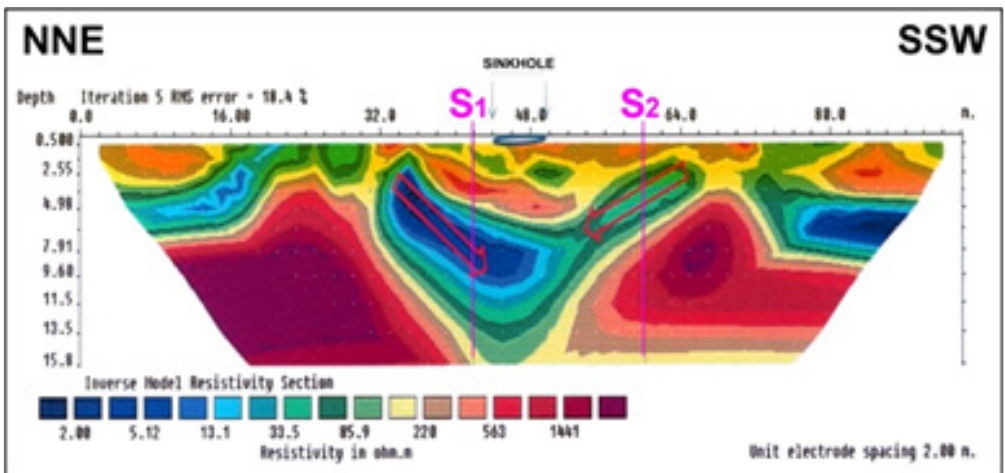
Figure 3: Electric tomography n.1: resistivity values and projection of cores drilling S1 and S2 (from Technical Department of the municipality of Turi (BA) – modified).